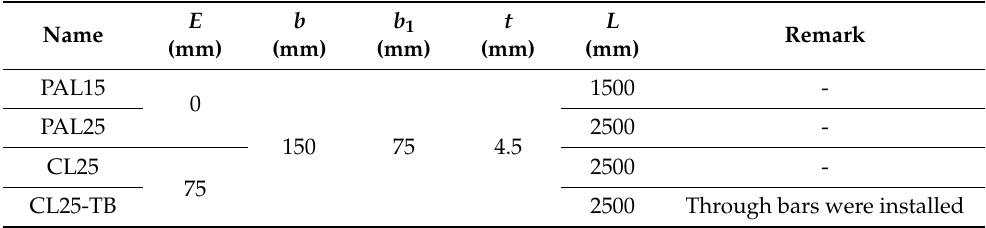
Table 1. Description of test specimens.